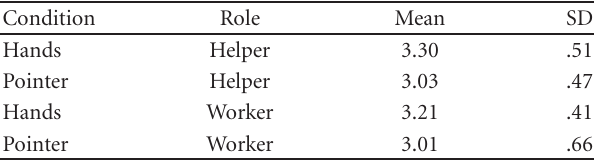
Table 2: Perception of quality of collaborative e ff ort